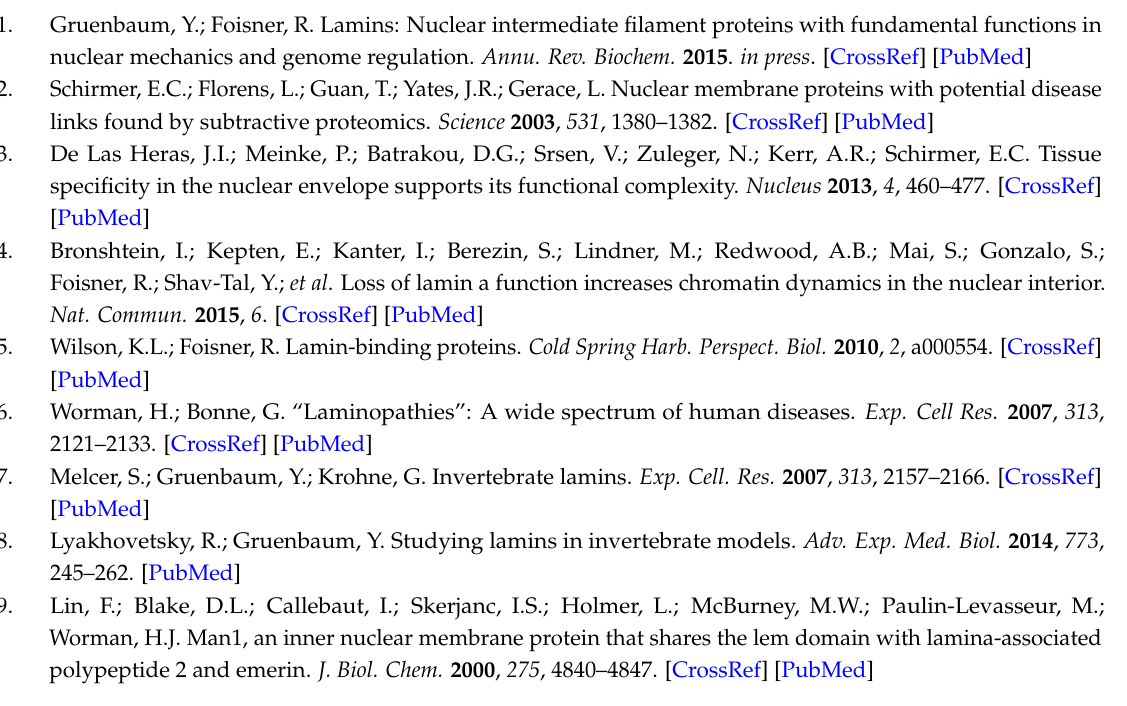
Figure S1: Matefin/SUN-1 piS8 and pS24 localization during cell cycle, Figure S2: RNAi screen of potential kinases involved in matefin/SUN-1 S43